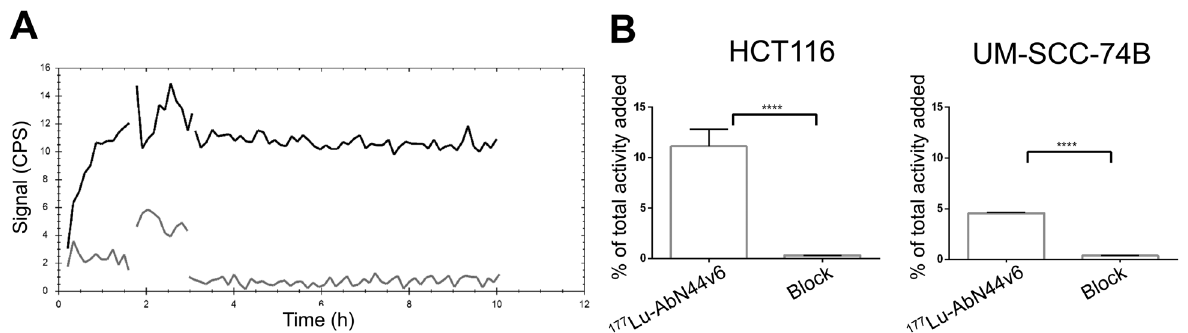
Fig. 1 a LigandTracer curve representing 177 Lu-AbN44v6 uptake and retention of HCT116 (black) and UM-SCC-74B (gray). b Specificity evaluation of 177 Lu-AbN44v6 using HCT116 and UM-SCC-74B. p < 0.0001 (****), n ≥ 3, error bars presented as